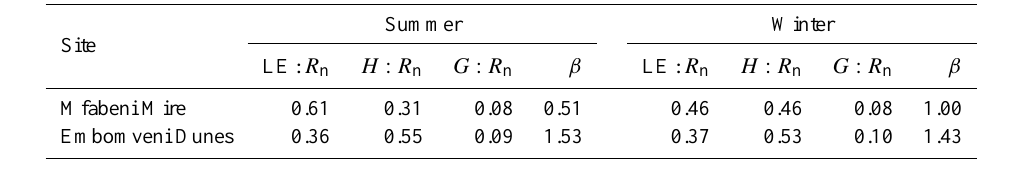
Table 1. Distribution of the average daily energy balance as fractions of R n , as well as the Bowen ratio ( β) , at the Mfabeni Mire and Embomveni Dune sites.